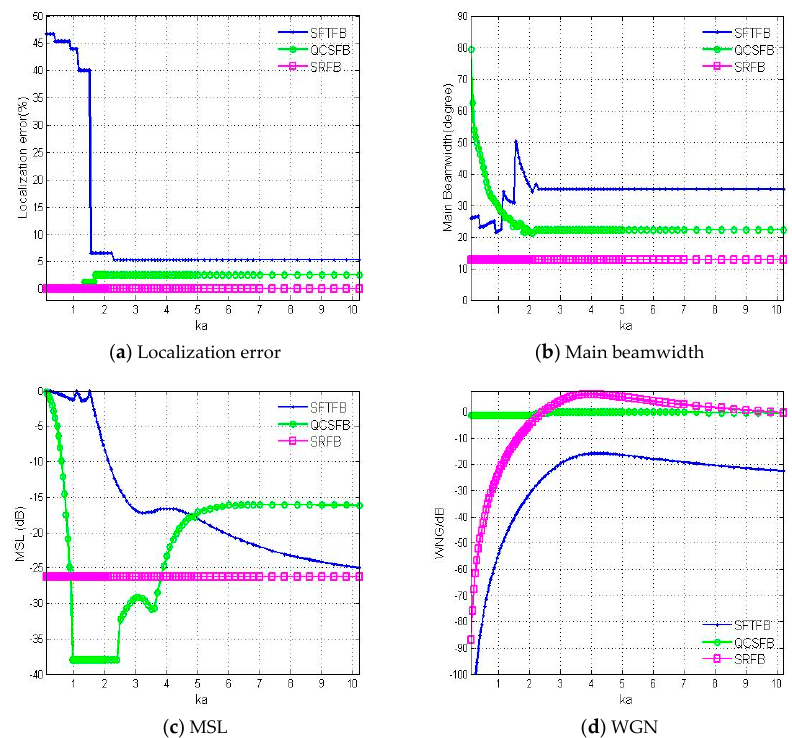
Figure 5. The performance of the three methods investigated based on the ( a ) localization error, ( b ) main beamwidth, ( c ) maximum sidelobe level (MSL) and ( d ) white noise gain (WNG) with respect to ka .